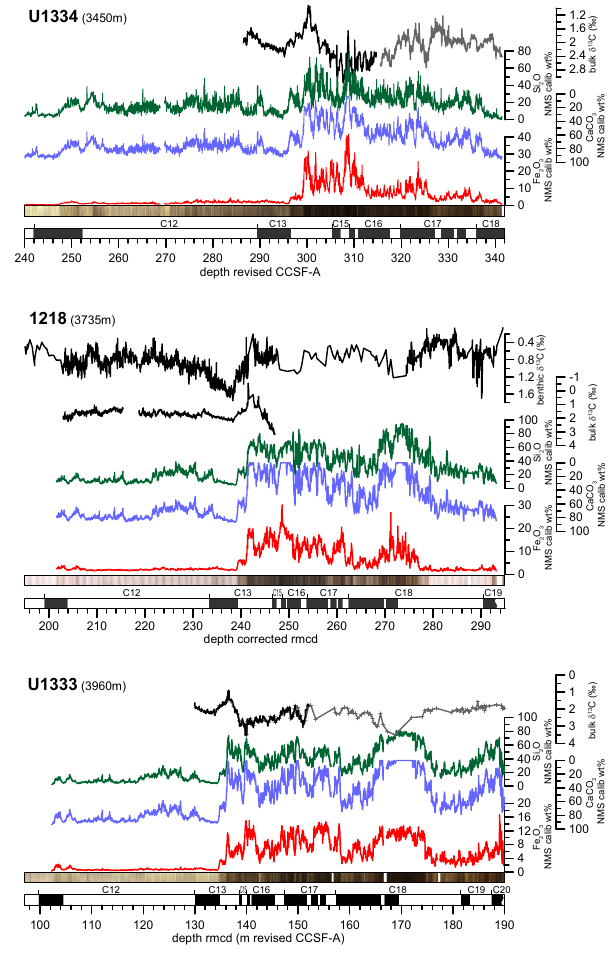
Figure 2. Overview of data from ODP Site 1218 and IODP Sites U1333/U1334 in the depth domain (in brackets the water depth of each site at 34Ma; Pälike et al., 2010). The plots show stable carbon isotope data (black, gray), normalized median scaled (NMS)wt% based on calibrated XRF core scanning data for Si (green), Ca (blue), and Fe (red) (for details see methods chapter), spliced core image, and magnetic polarity reversal pattern transferred to 1218 and U1334 by correlation to U1333 (Pälike et al., 2010; Westerhold et al., 2012a). Data sources: all XRF core scanning data from this study; bulk δ 13 C U1334 from Wilson et al. (unpublished) (black) and this study (gray), 1218 from Coxall et al. (2005) (black), U1333 from Wilson et al. (unpublished) (black), and Leon-Rodriguez and Dickens (2013) (gray); benthic ( Cibicidoides spp.) δ 13 C of 1218 from Lear et al. (2004), Coxall et al. (2005), Tripati et al. (2005), and Coxall and Wilson